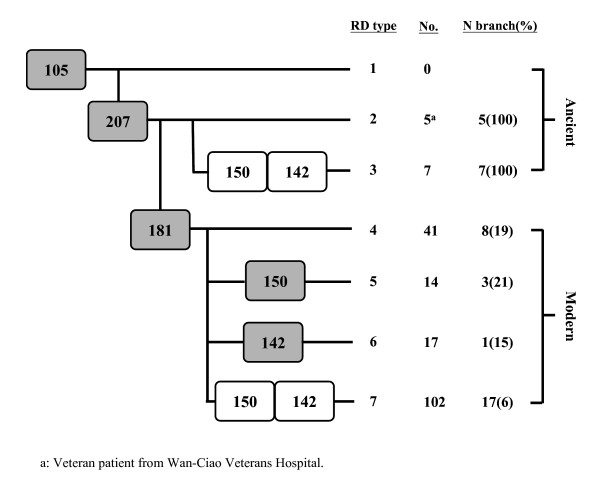
Beijing family subgroup structure. Scheme of the proposed evolutionary pathway of the Beijing lineages, based on the deletion of genomic regions (RD, region of difference) showed inrectangles and on the NTF region with IS6110 insertions. The gray rectangles are lineages that have been reported previously, while the white rectangles represent proposed new lineages that are identified in the current study study.